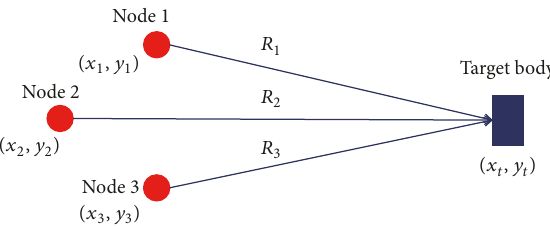
Figure 6: Diagram of solving equation